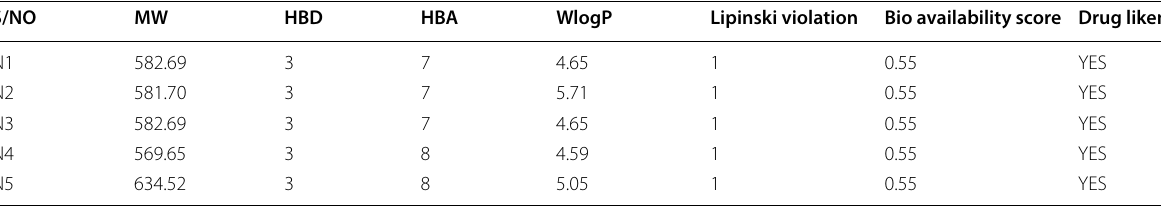
Table 8 Predicted Drug-likeness properties of the designed compounds S/NO MW